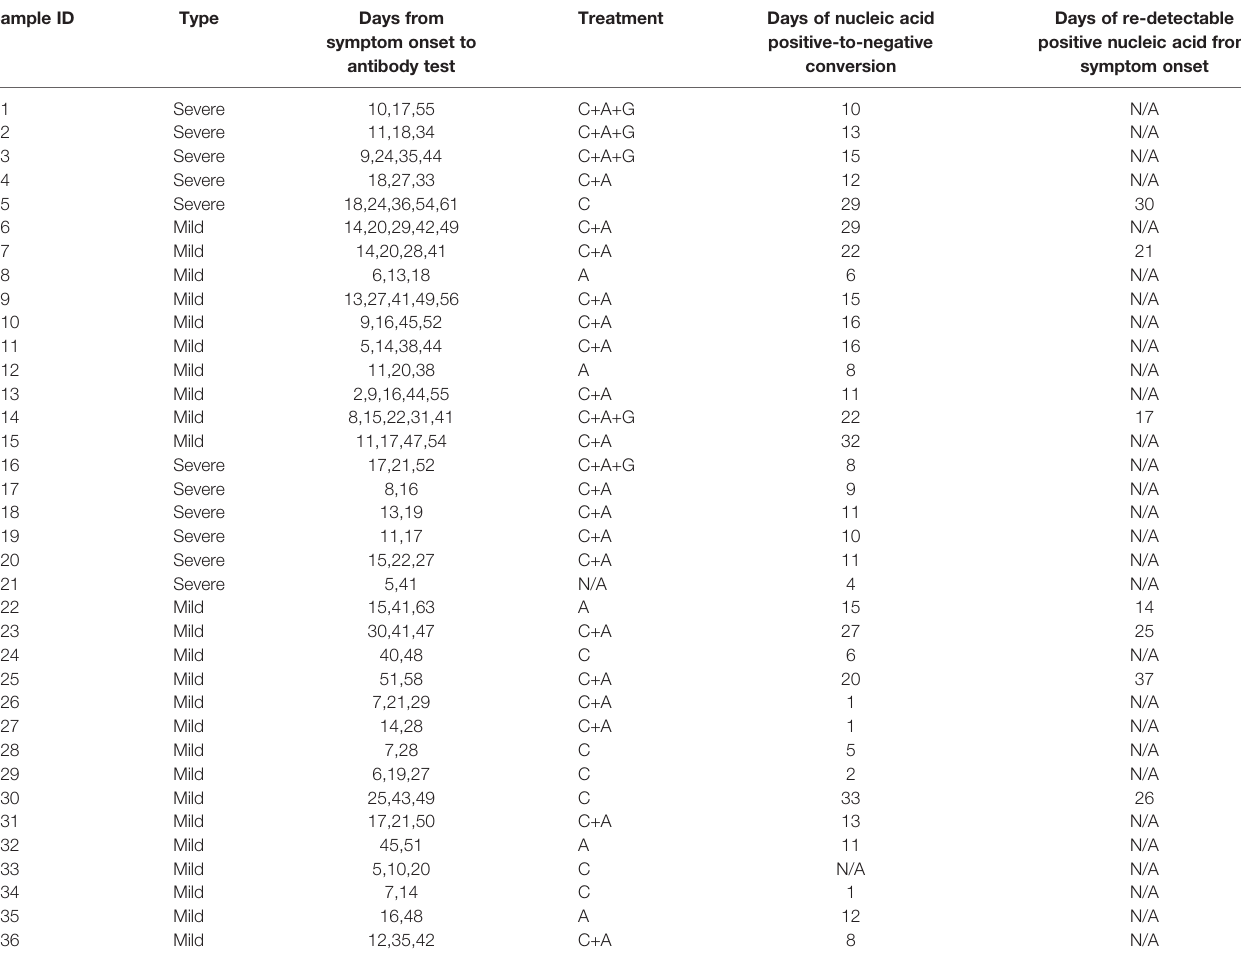
TABLE 1 | Clinical information of COVID-19 patients. Sample